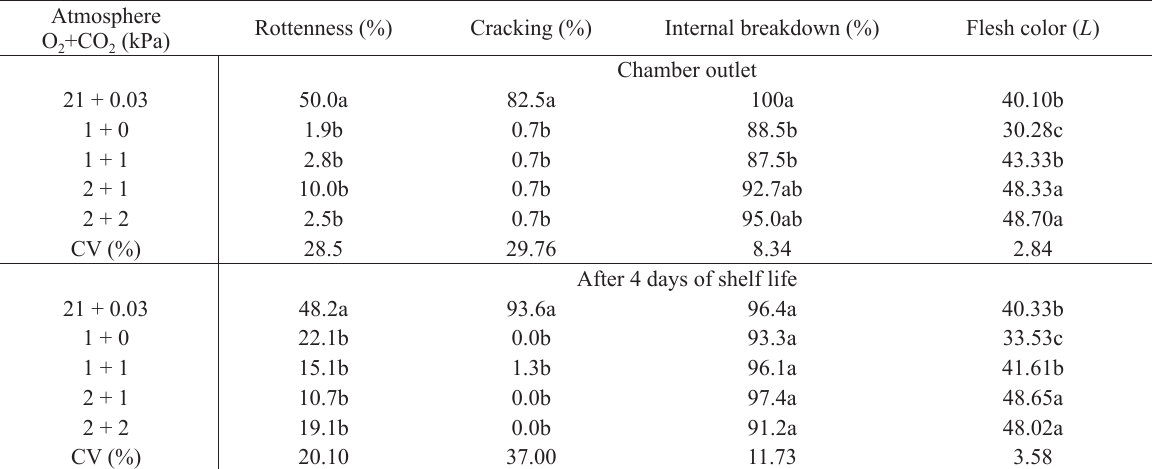
Incidence of rottenness, cracking and internal breakdown and color ( L ) in ‘Laetitia’ plums stored at 0.5 ° C under different atmospheres for 60 days and four days